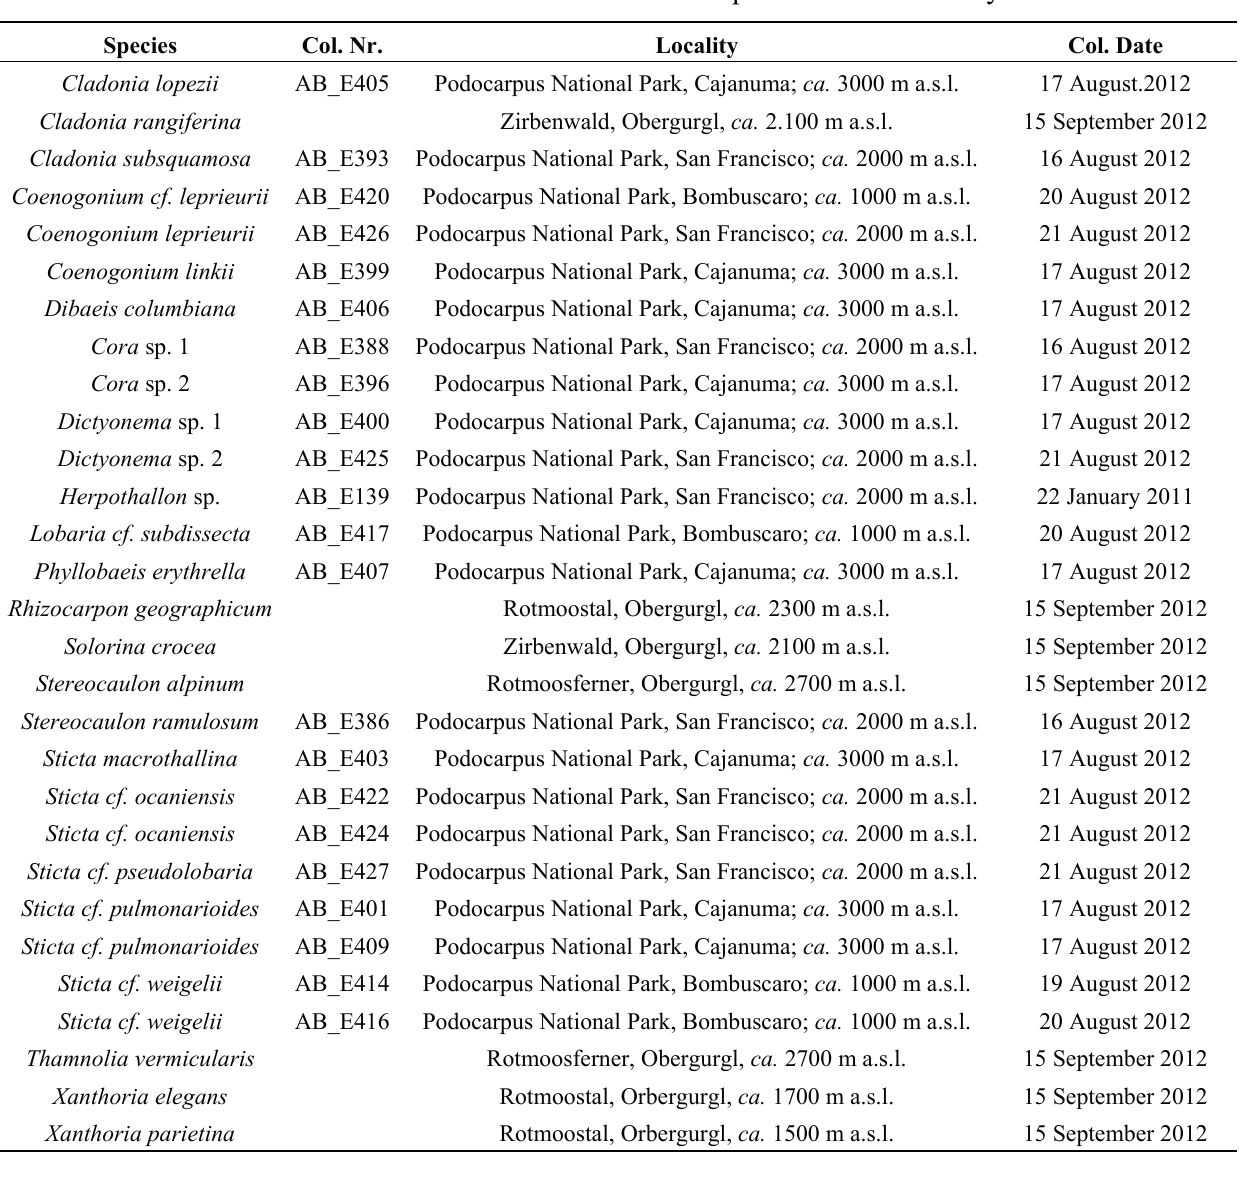
Table 3. Collection details for the lichen specimens of this